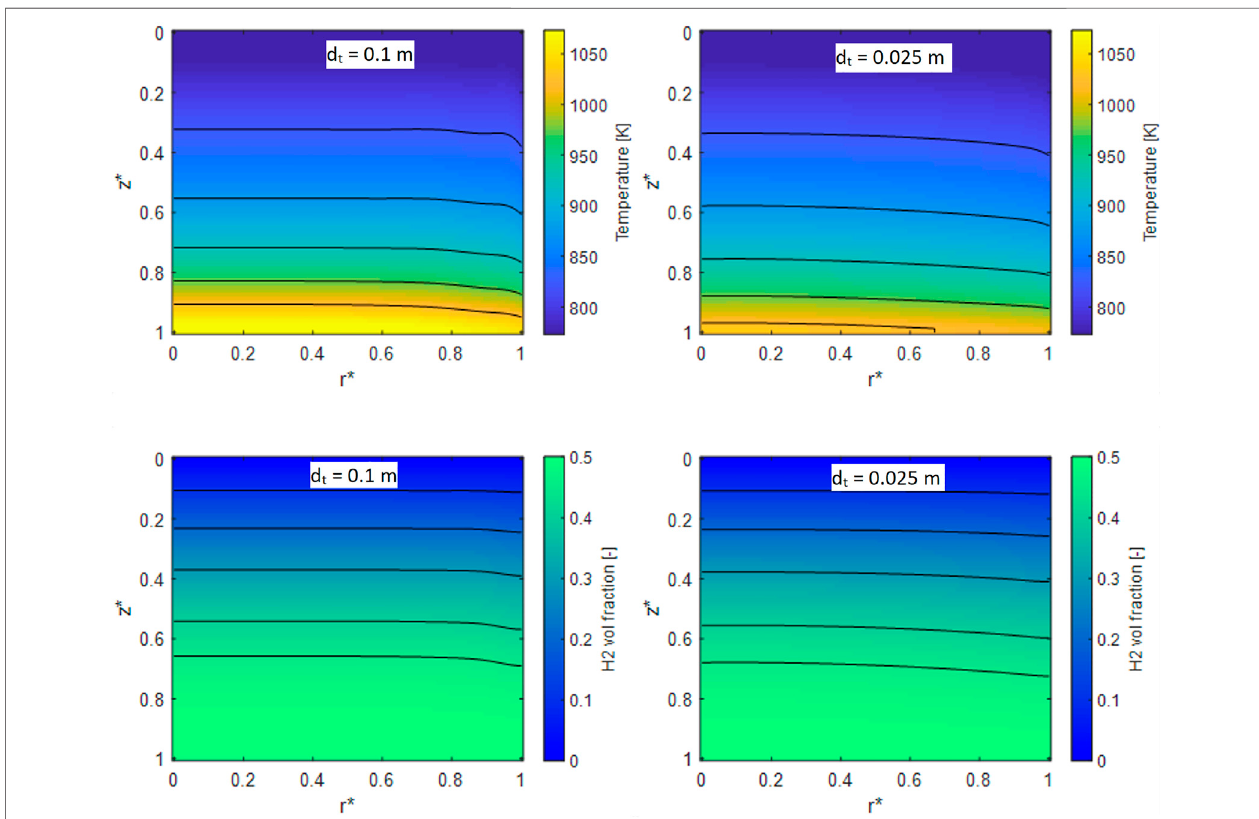
FIGURE 11 | 2D temperature maps for a reformer operated at GHSV (cid:2) 10.000 h − 1 and with a diameter of 10 cm (A) , 2.5 cm (B) . 2D H 2 volumetric fraction for a reactor with dt (cid:2) 10 cm (C) and 2.5 cm (D) .